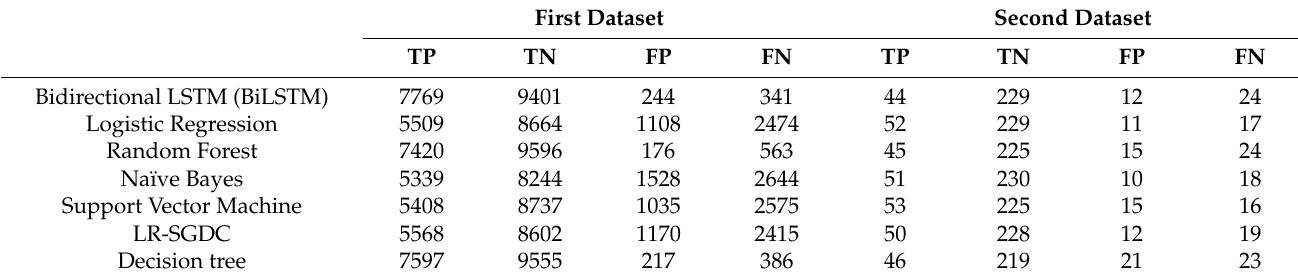
Table 5. Confusion matrix of different classifiers for both the datasets.